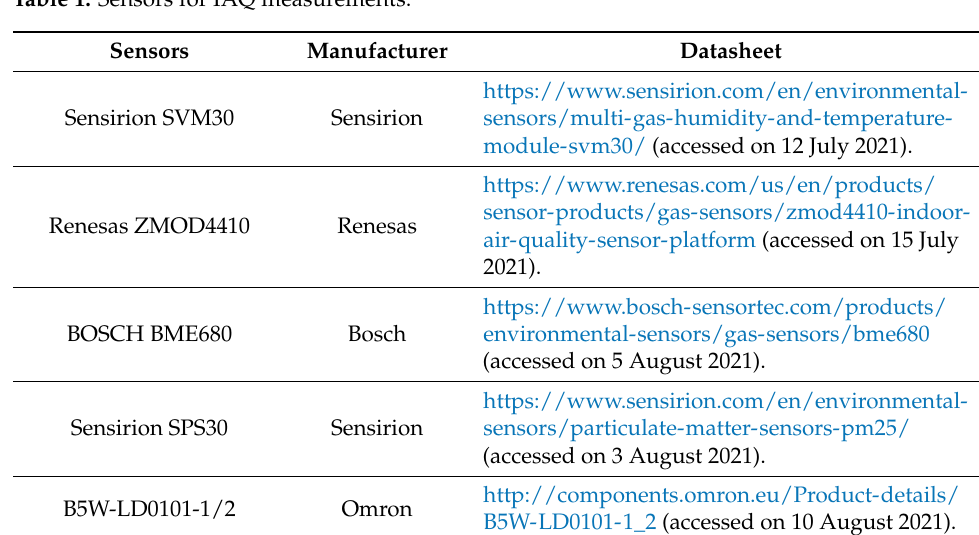
Figure 3. Block diagram of the proposed system’s architecture. Table 1. Sensors for IAQ